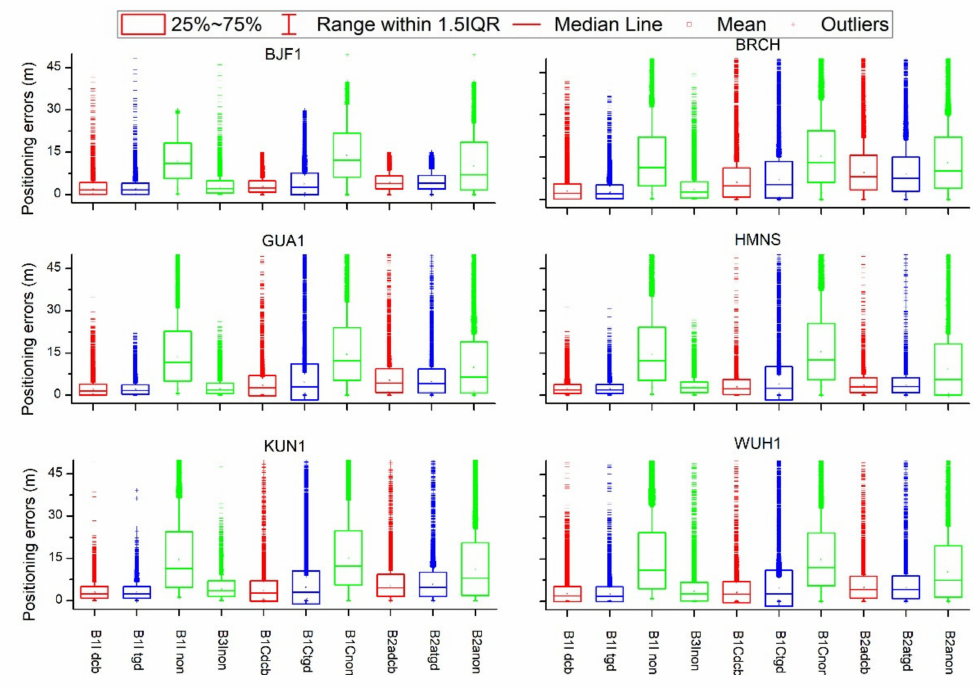
Figure 12. Boxplot of the 3D positioning errors for single-frequency SPP distributions in the non-corr (green), dcb-corr (red) and tgd-corr (blue) and schemes for the period of April